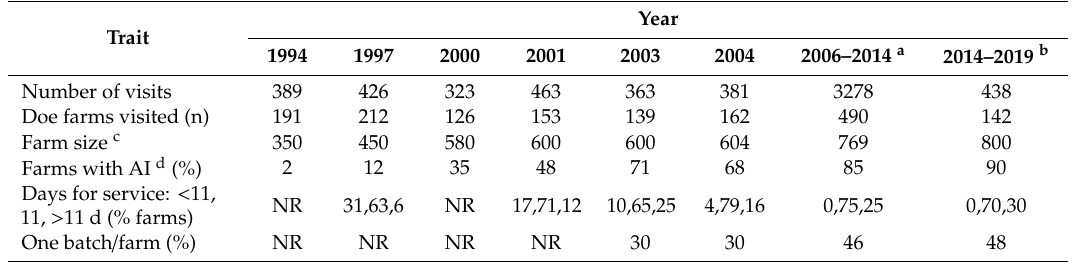
Table 1. Traits of doe farms visited in Spain and Portugal between 1994 and 2019.